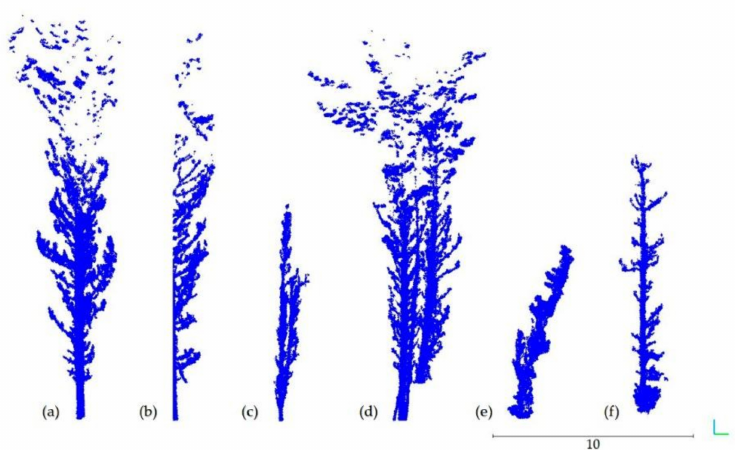
Figure 8. Selection of errors encountered in the segmentation process. ( a ) Tree F43—clear segmenta- tion with accurate DBH; ( b ) tree D26—stem cut in half vertically in tiling process; ( c ) tree G4—forked tree with additional leader diverging from the main stem below DBH height; ( d ) tree O40—inclusion of more than one tree as a single segment; ( e ) tree G47—considerable needle noise at DBH height and ( f ) tree T41—understorey points attached to